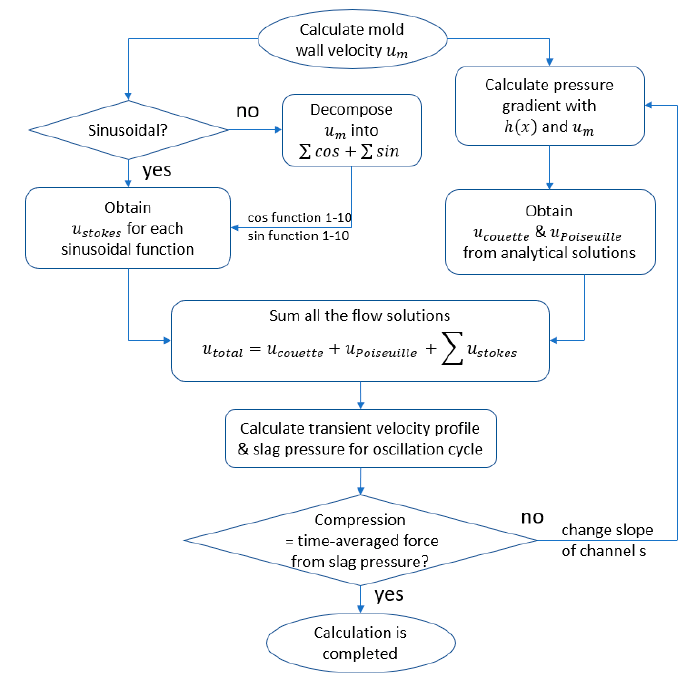
Figure 6. Flow chart for the analytical model algorithm.